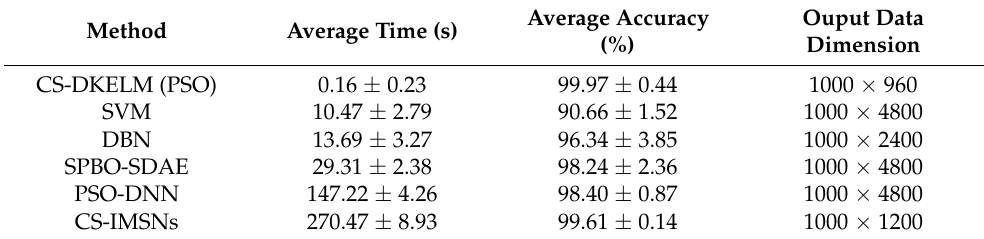
Table 6. Comparison of output results of different